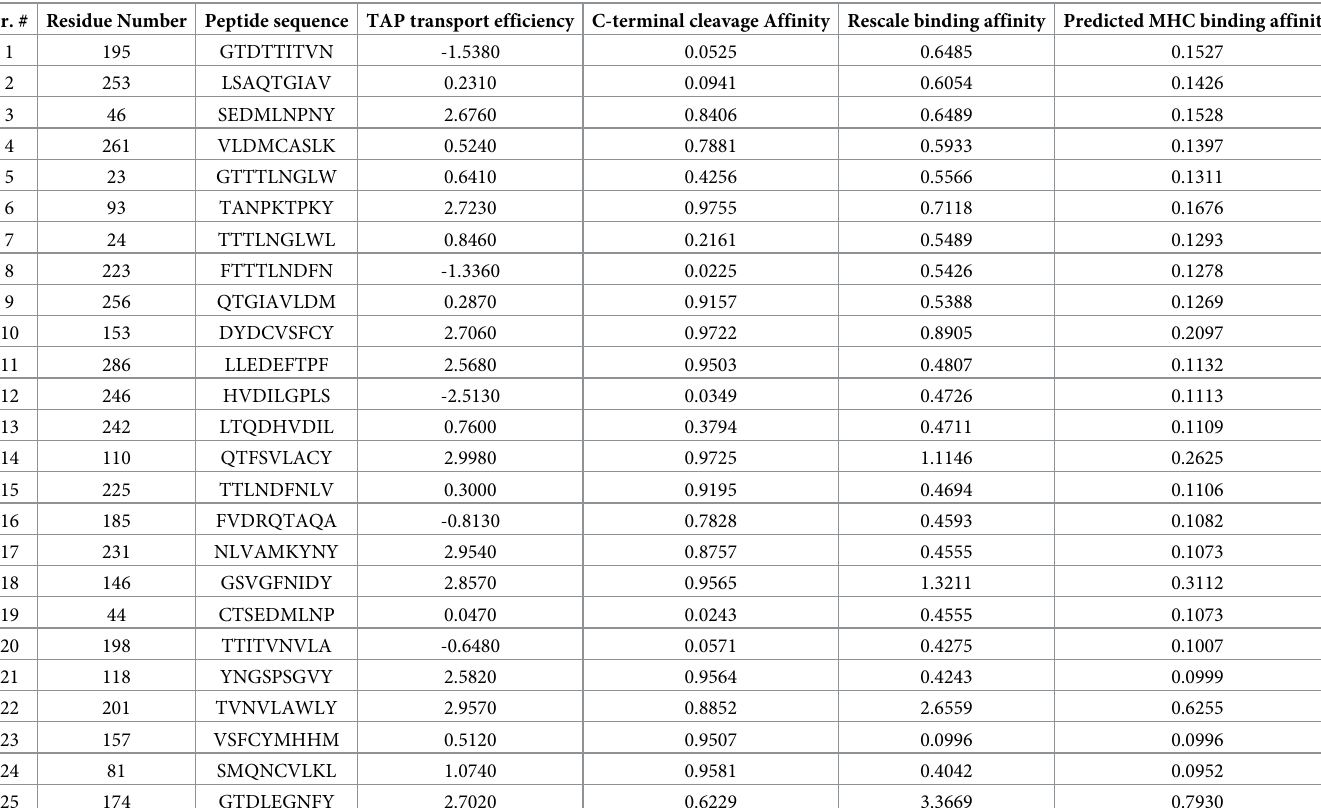
Table 1. Predicted CTL epitopes and predicted amino acid residues from the